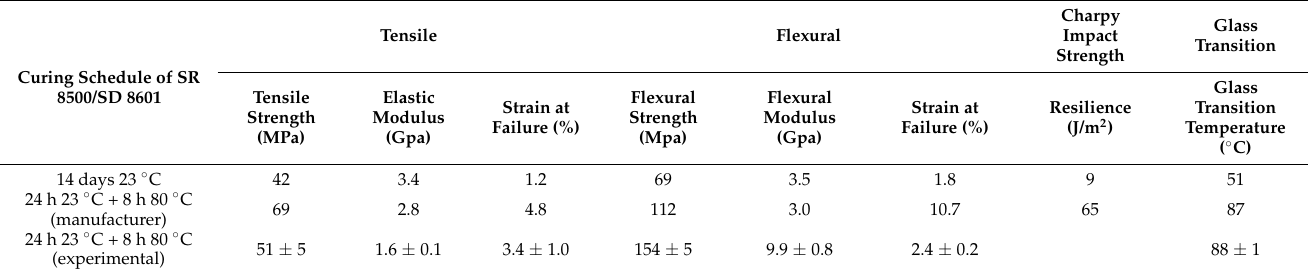
Table 1. Mechanical properties of the epoxy system SR 8500/SD 8601, as reported in the PDS for the first two rows [39] and experimental data obtained by the authors for the last row.